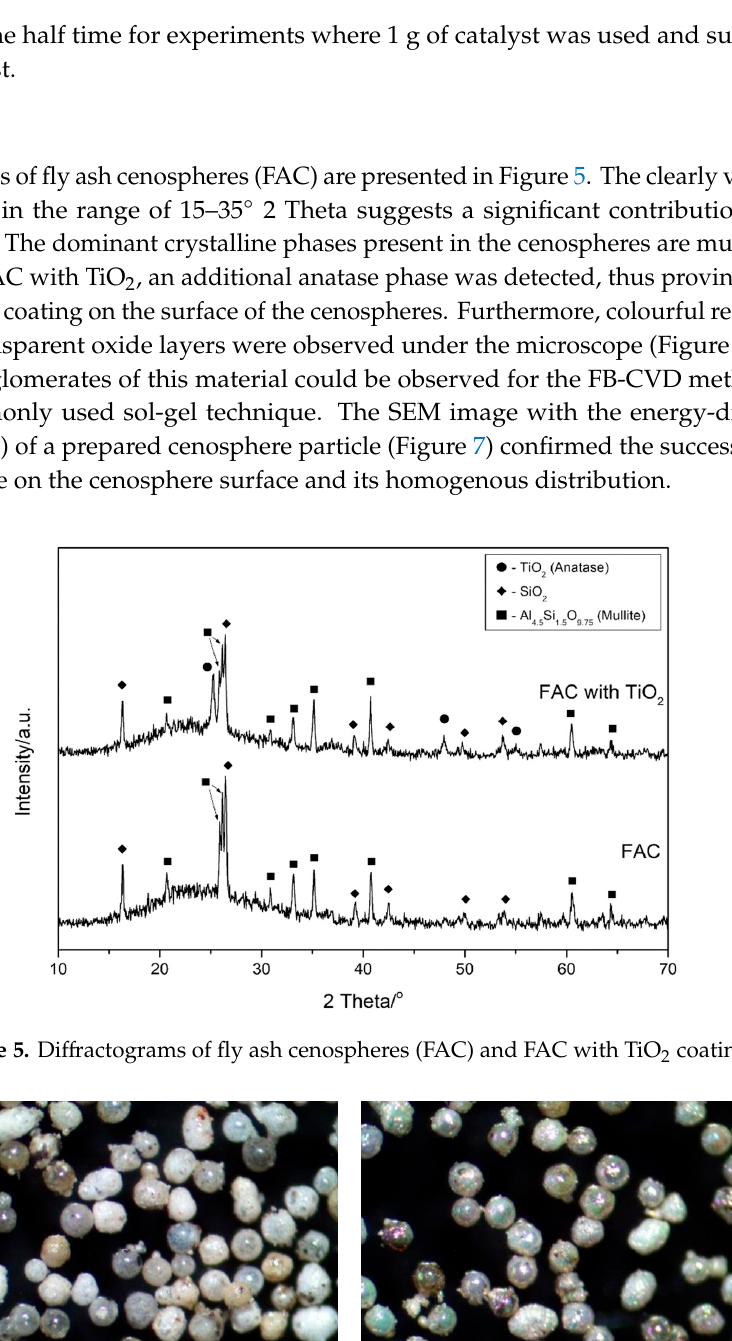
Figure 6. Microscopic photographs of tested materials (40 ×): ( a ) FAC, ( b ) FAC with TiO 2.